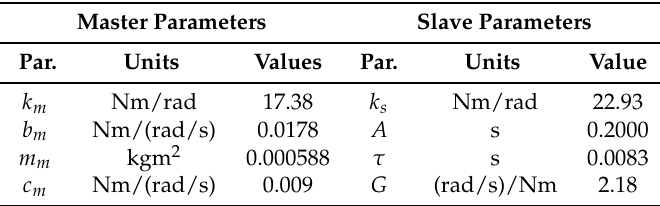
Table 1. Control parameters of the master and the slave